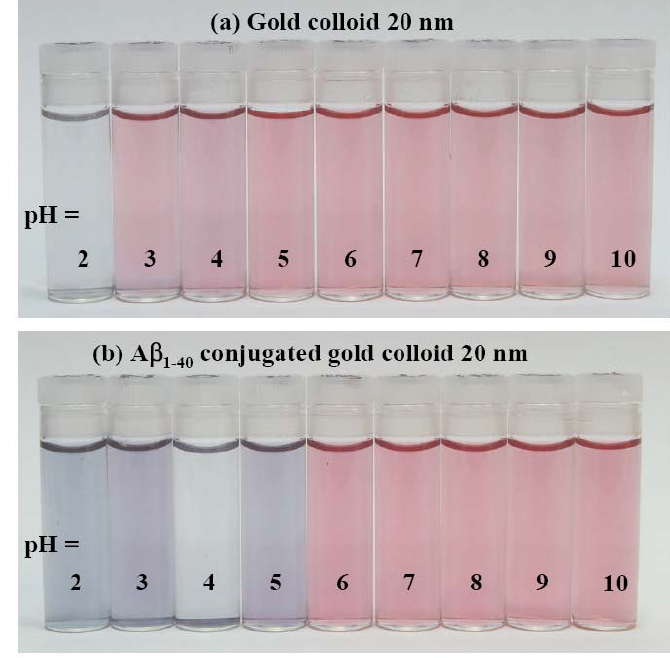
Figure 2. Visual evidence of the effect of pH on a colloidal gold nanoparticle solution. (a) The color of the solution of gold colloidal nanoparticle with size 20 nm. (b) The color of 20 nm colloidal gold nanoparticles coated with A  1-40